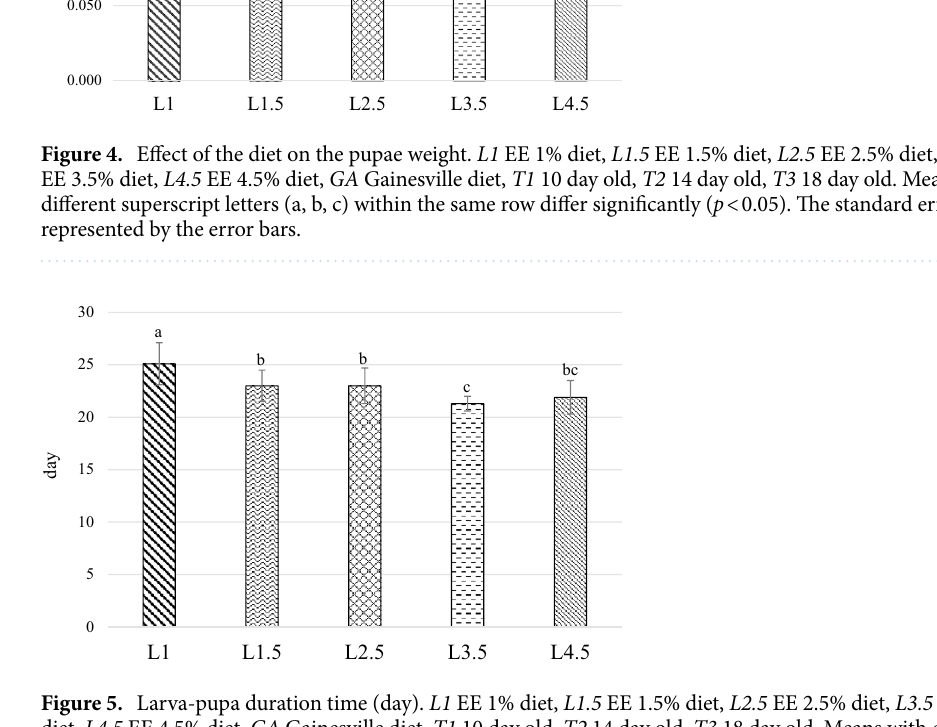
Figure 5. Larva-pupa duration time (day). L1 EE 1% diet, L1.5 EE 1.5% diet, L2.5 EE 2.5% diet, L3.5 EE 3.5% diet, L4.5 EE 4.5% diet, GA Gainesville diet, T1 10 day old, T2 14 day old, T3 18 day old. Means with different superscript letters (a, b, c) within the same row differ significantly ( p < 0.05). The standard error is represented by the error